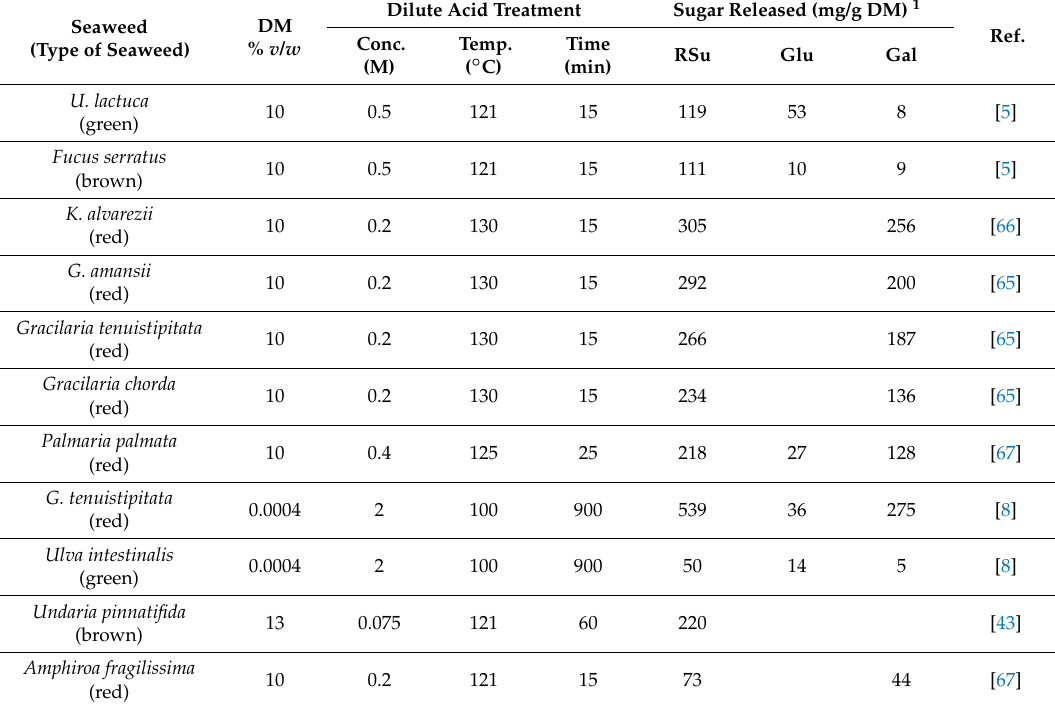
Table 3. Comparison of dilute acid hydrolysis conditions and their sugar